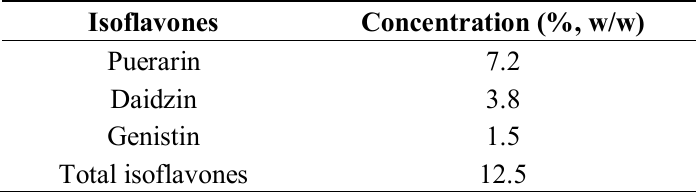
Table 1. Composition of puerarin and other isoflavones from P. lobata